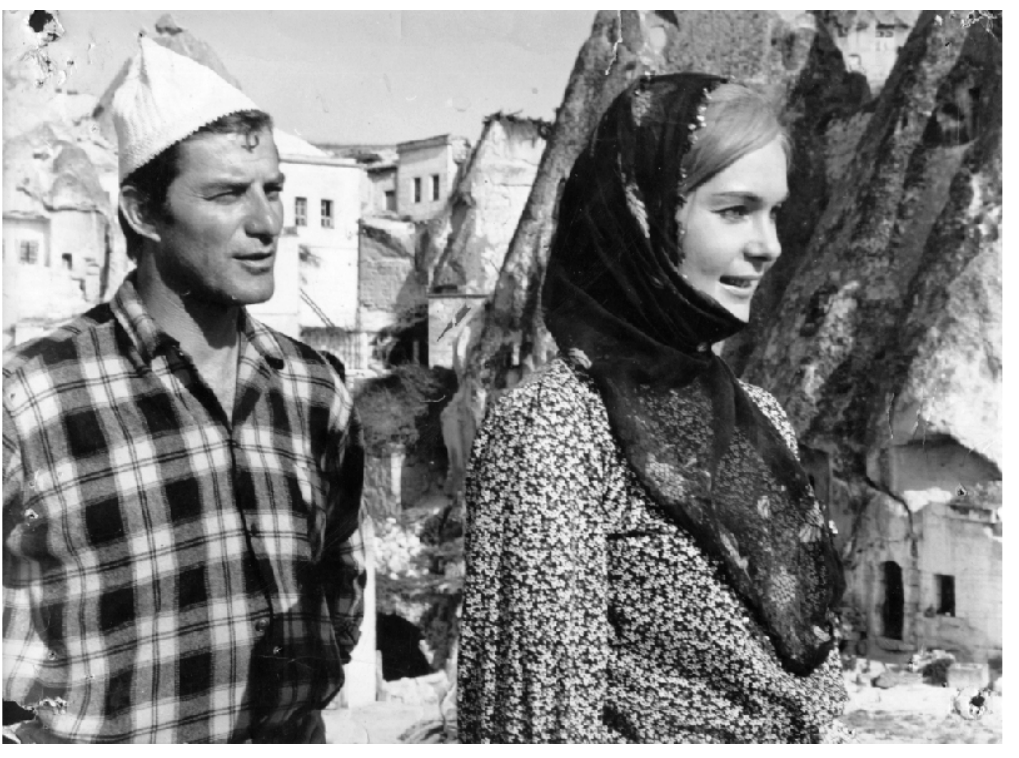
Figure 4: Eva finds true peace in Islam and the authentic Turk,